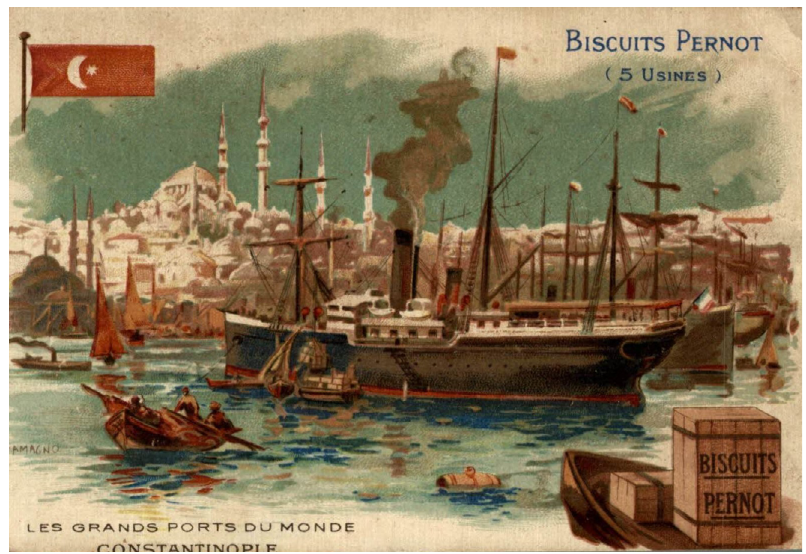
FIG. 4 Front of the trade card advertising Pernot biscuits in the port of Constantinople. Author’s